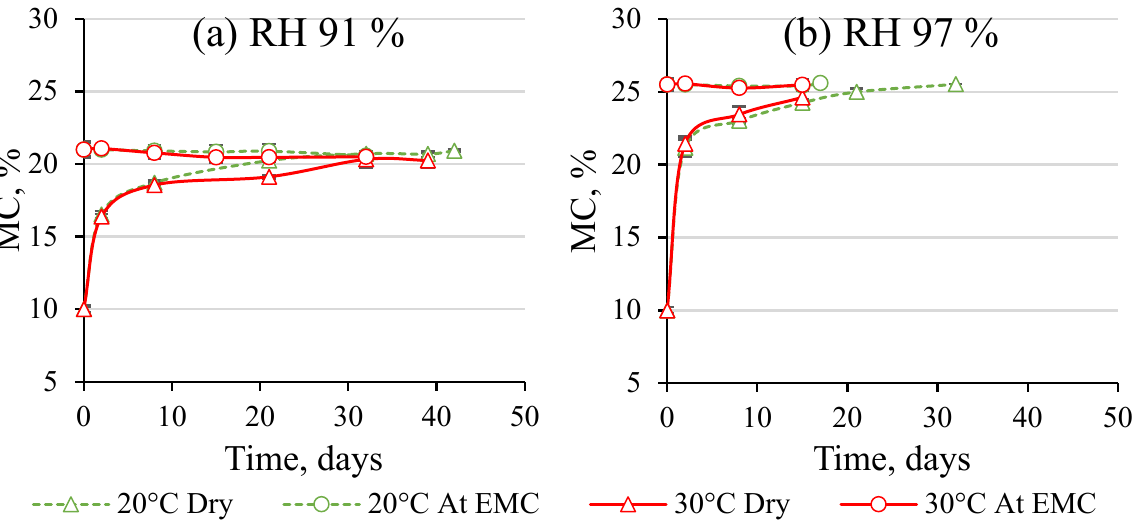
Figure 6. Changes in moisture content (MC) of ‘Dry’ (prior the test conditioned at RH 50%) and ‘At EMC’ (prior the test conditioned at 91 or 97%) specimens exposed to constant conditions: tempera- ture (20 °C and 30 °C) and humidity ( a ) RH 91% and ( b ) RH 97%. Some effect of wood MC on mould development was only observed for the specimens exposed to an environment of RH 91% and a temperature 20 ◦ C when significantly less time was needed for mould germination on the ‘At EMC’ specimens (Figure 7). These specimens were detected reaching the visible mould growth stage more rapidly compared with their ‘Dry’ counterparts. However, the difference in the time to reach visible mould growth between the ‘Dry’ and ‘At EMC’ specimens was not significant ( p > 0.05) for any of the environmental conditions. These results suggest that the wood MC is not of significant importance for mould development, at least under the studied conditions of high RH. The findings agree with the other studies [15,16].